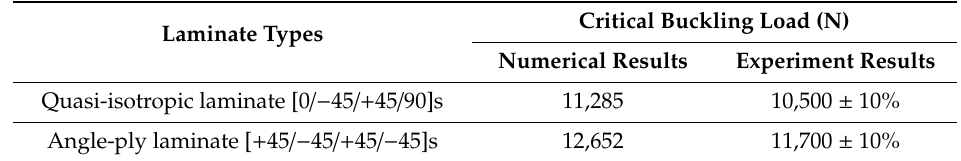
Table 3. Comparison of the Critical Buckling Load between the Numerical and Experimental Results.